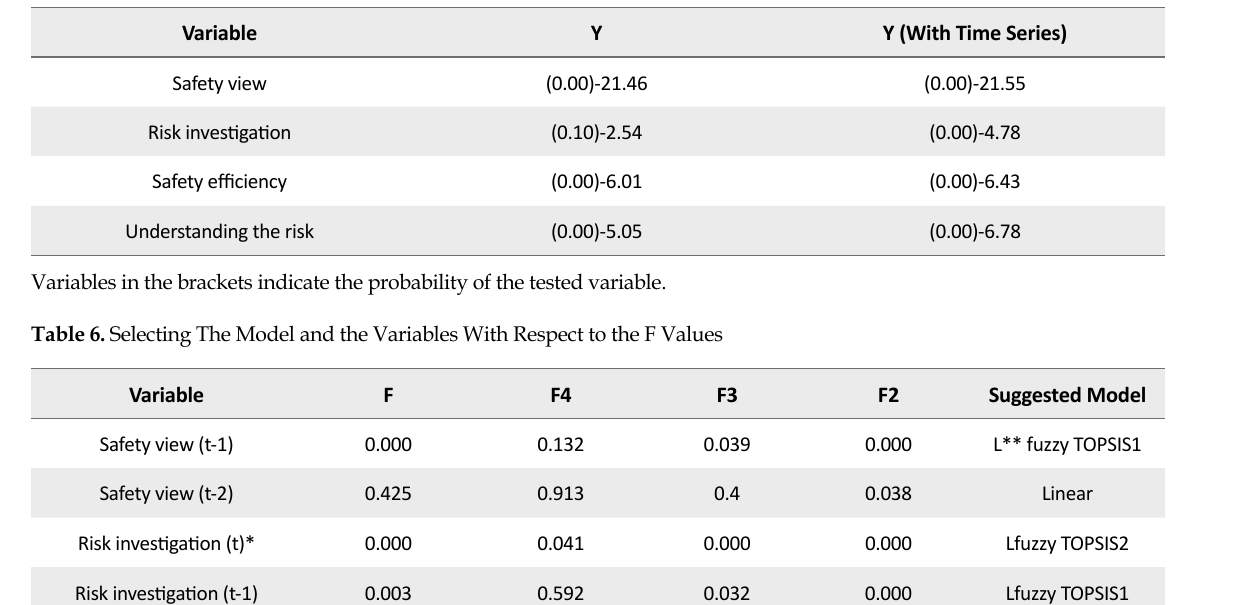
Table 5. Philips and Perron Root Test for the model variables